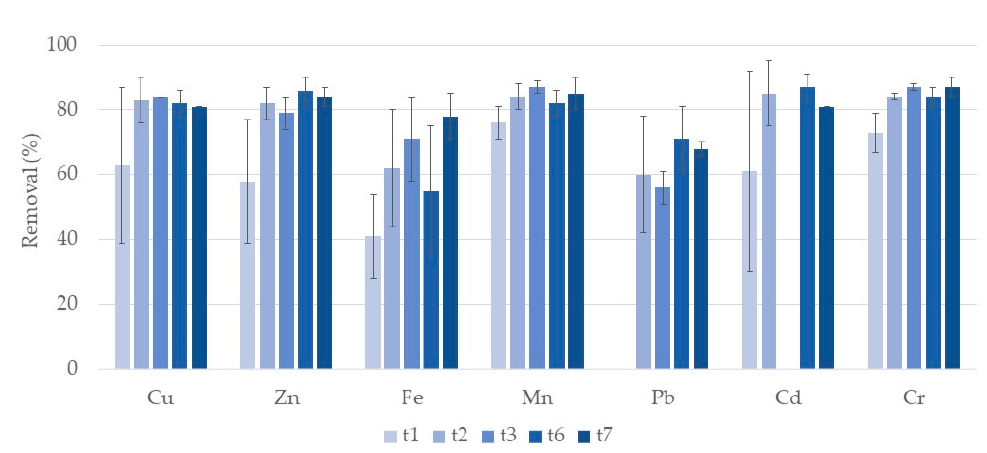
Figure 4. Removal percentage and respective standard deviation ( n = 3) for each metal, in CWs with expanded clay (A) and T. latifolia during the first week of treatment. Samples taken after one day (t1), two days (t2), three days (t3), five days (t5), six days (t6), and seven days (t7) of treatment. There was no removal of Cd at t3.